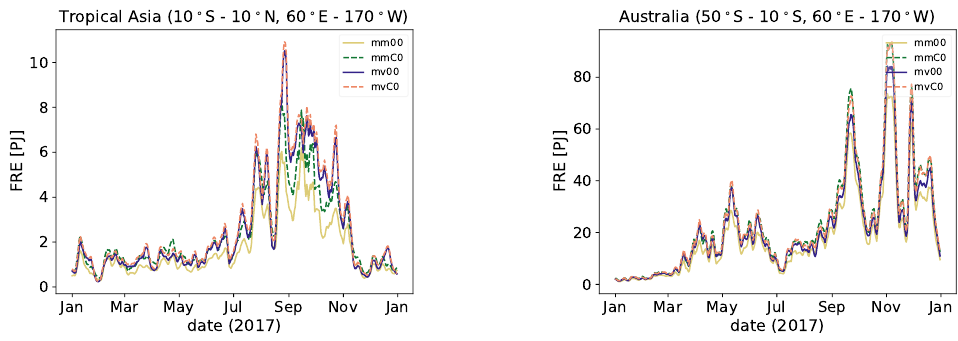
Figure 6. The subfigures show the daily fire radiative energy (FRE) of 2017 as estimated from different experiments with Global Fire Assimilation System (GFAS) over several regions around the globe. The region name and the latitude/longitude extent are described in the title of each sub-figure. The details of the experiments: mm00: Uncorrected gridded-FRP from MODIS/Aqua and MODIS/Terra are used as input. mv00: Uncorrected gridded-FRP from MODIS/Terra and VIIRS/Suomi-NPP are used as inputs. VIIRS/Suomi-NPP is used as a replacement for MODIS/Aqua. mmC0: Corrected gridded-FRP from both MODIS/Aqua and MODIS/Terra are used as inputs. mvC0: Corrected gridded-FRP from MODIS/Terra and gridded-FRP from VIIRS/Suomi-NPP are used as inputs. See also Table